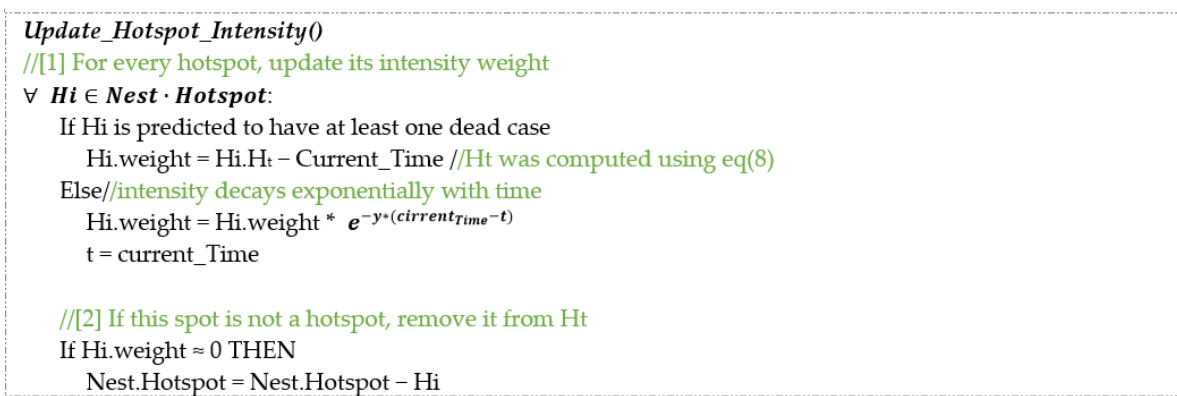
Figure 4. ED_Foraging “Hotspot Intensity function”.